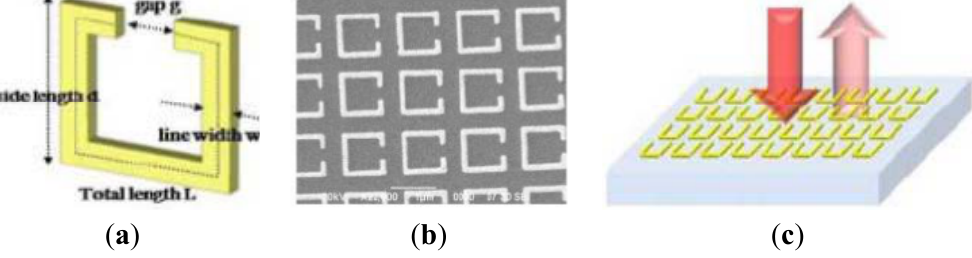
Figure 10. ( a ) The designed SRR unit cell; ( b ) SEM images of fabricated planar SRRs; ( c ) Schematic reflectance measurement upon the SRR-based plasmonic sensor. Here no optical coupler is required to excite plasmonic resonance. The details of the measured geometric parameters of five samples can be found in supporting information